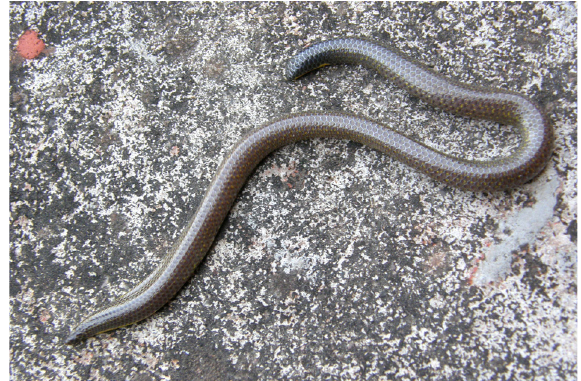
Image 5. Uropeltis ellioti - full view